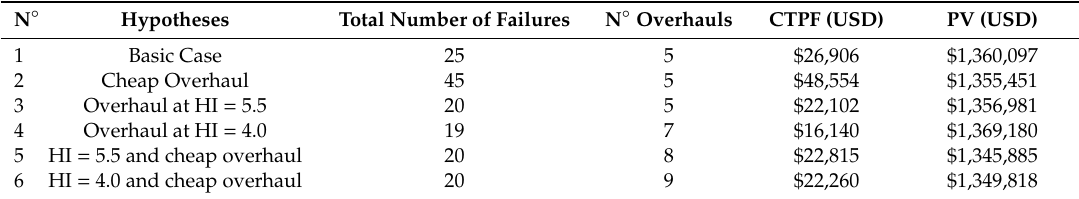
Table 13. Calculation of annual failures